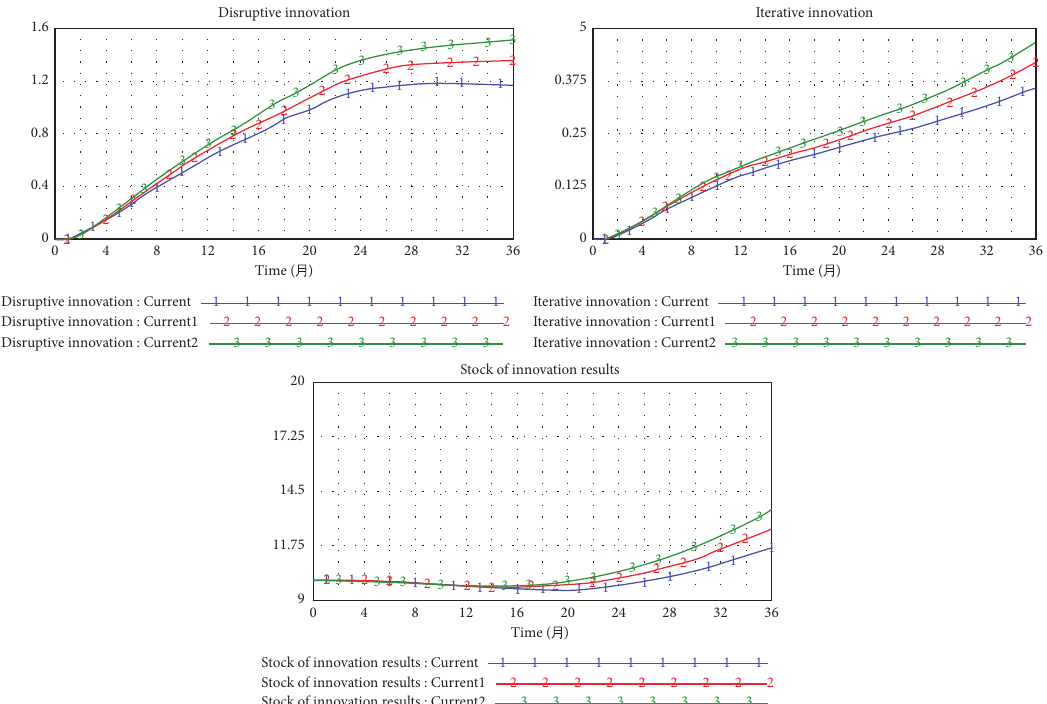
Figure 5: The impacts of digital resources on iterative innovation, disruptive innovation, and stock of innovation results.